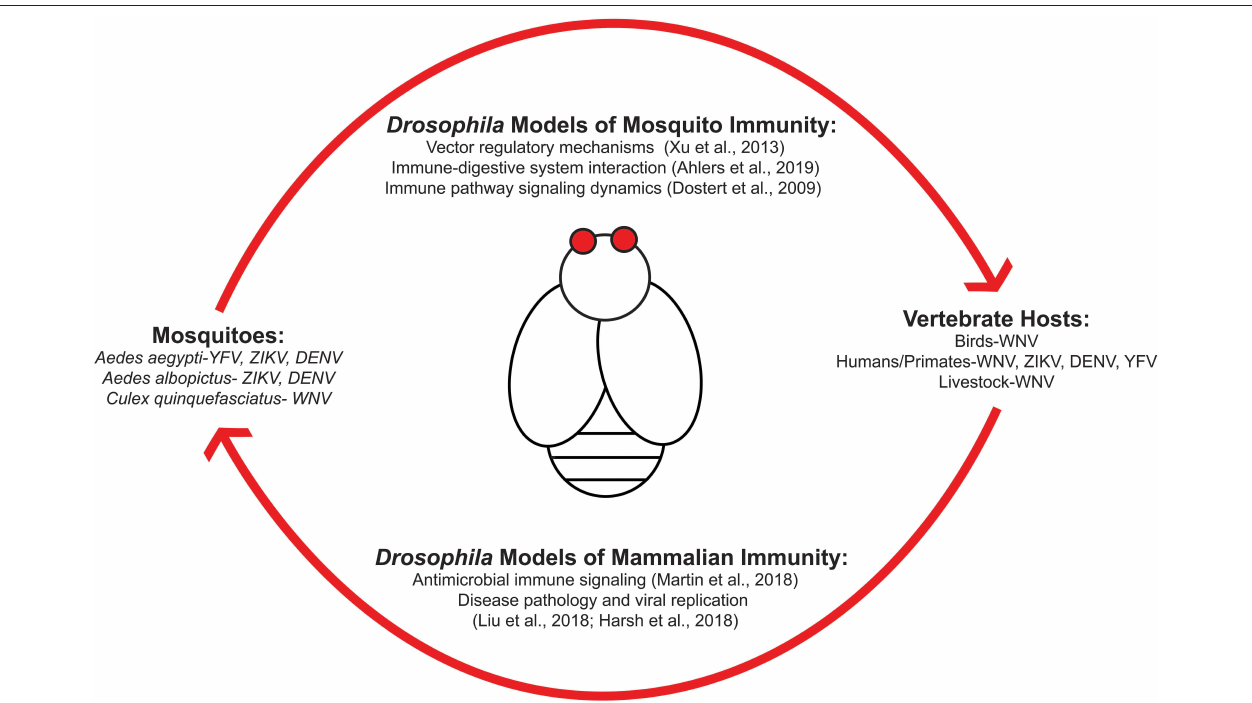
FIGURE 1 | Drosophila melanogaster are an ideal model organism for studying host-arboviral interactions. Various arboviruses utilize mosquitoes as reservoirs and vectors for transmission into vertebrate hosts. This can include species that are either involved in viral replication and spread (such as bird populations for West Nile virus) or dead-end host that become infected without being able to properly propagate viral replication for further spread (i.e., humans). Transmission is accomplished via a bloodmeal exchange. Drosophila possess orthologous host response pathways found in mosquitoes and humans, making it an ideal model organism for studying transmission dynamics and host-pathogen interactions at both vector and human